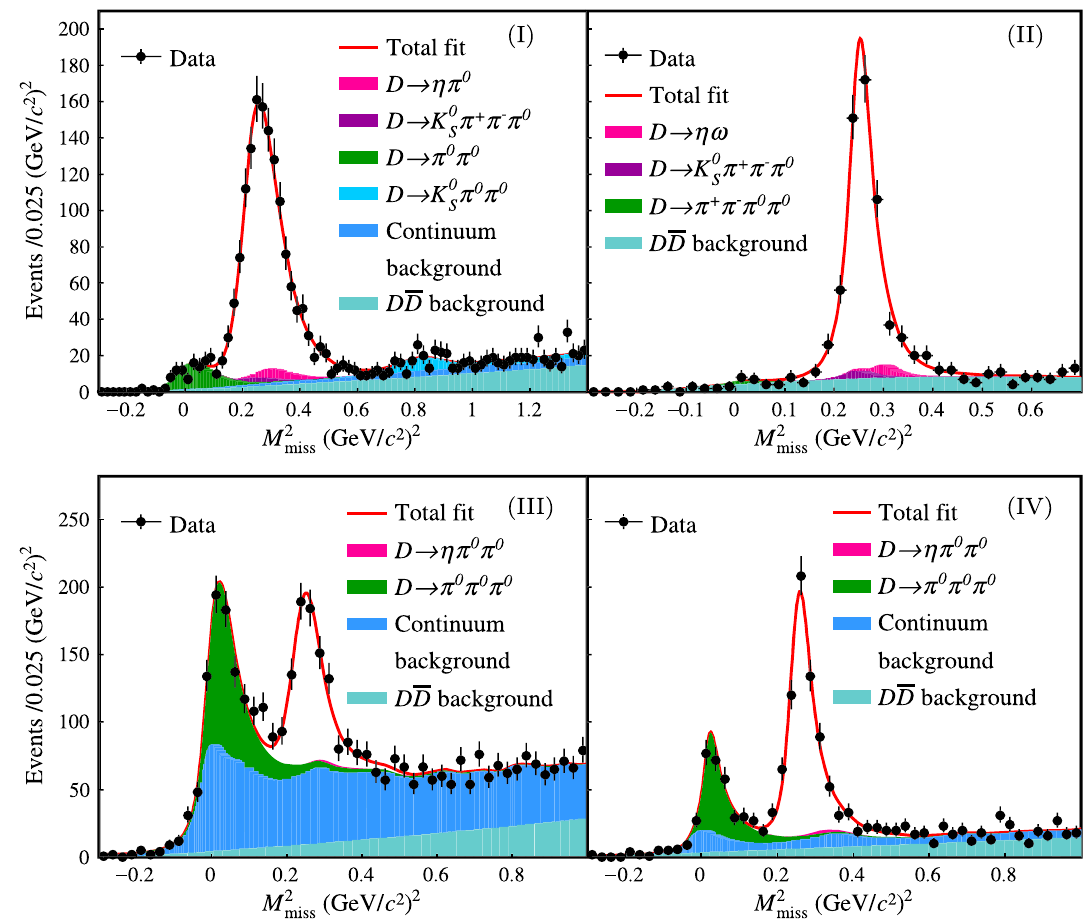
π 0 candidates (I), D → K 0 L